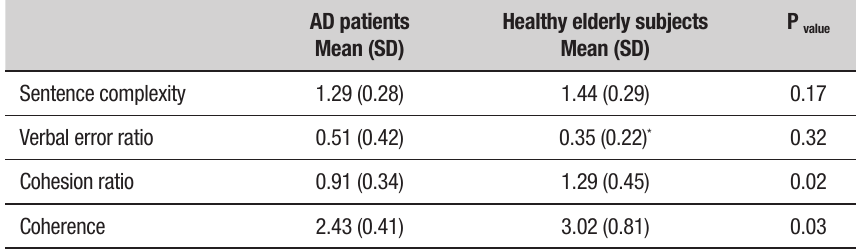
Table 2. Narrative discourse features in patients with Alzheimer’s disease and healthy elderly